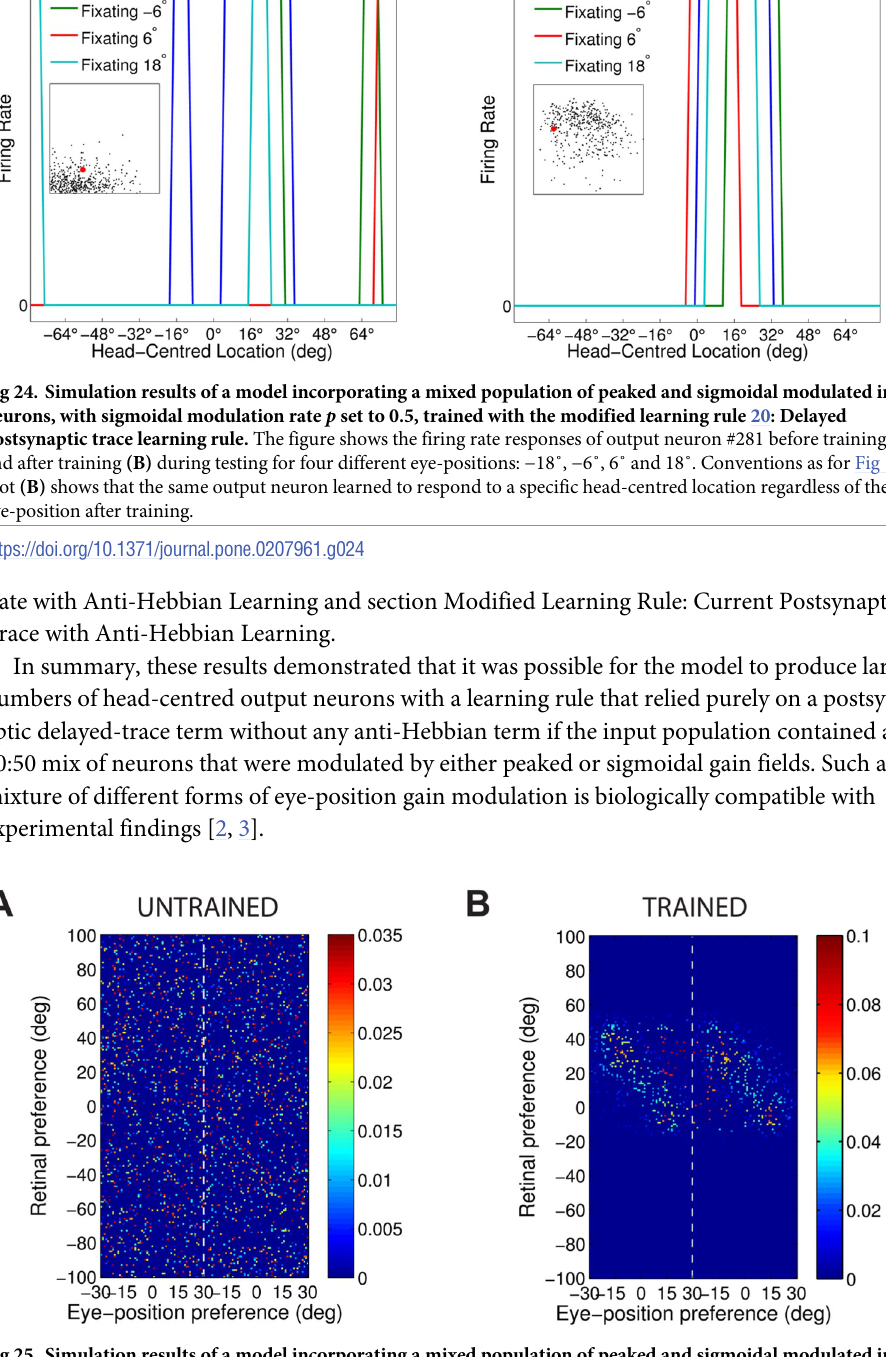
Fig 25. Simulation results of a model incorporating a mixed population of peaked and sigmoidal modulated input neurons, with sigmoidal modulation rate p set to 0.5, trained with the modified learning rule 20: Delayed postsynaptic trace learning rule. The figure shows the strengths of the afferent synapses from the input population to output neuron #281 for the untrained (A) and trained (B) model. The output neuron corresponds to the one plotted in Fig 24. Conventions as for Fig 13. The synaptic weight structure for this output neuron after training shown in plot (B) has the correct kind of profile for a head-centred neuron (Fig